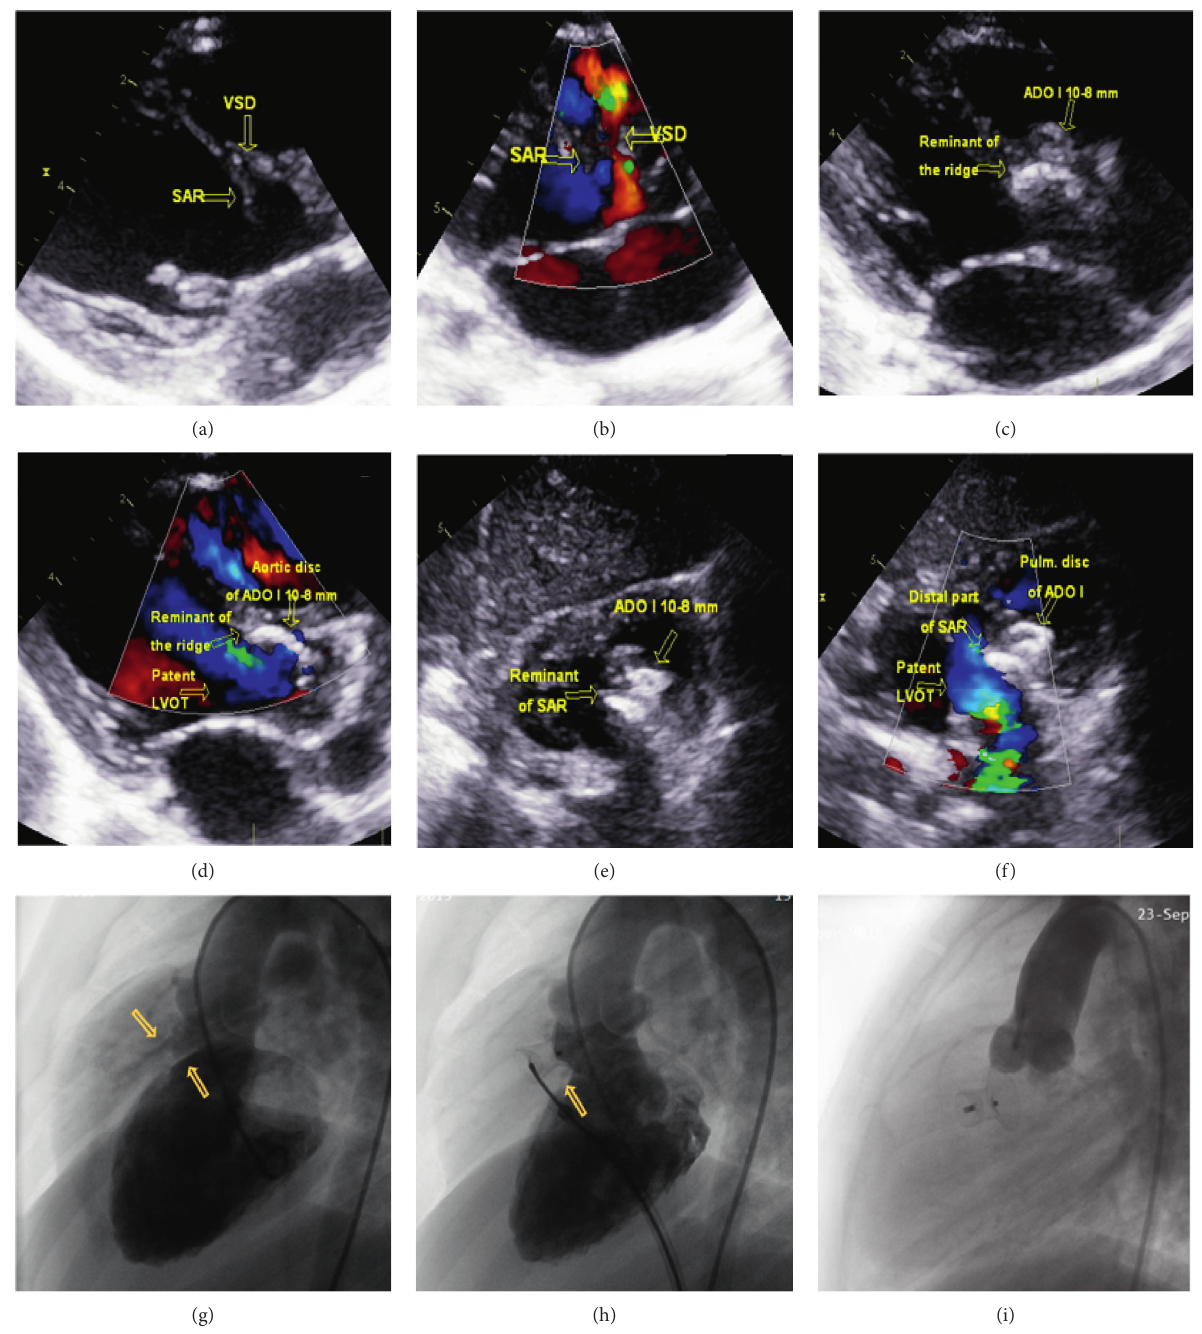
Figure 3: (a) Cross-sectional echocardiogram in the long axis parasternal view of a four-year-old male patient demonstrates peri- membranous subaortic VSD (upper arrow) distal to the subaortic ridge (lower arrow). (b) Parasternal long axis 2D echocardiographic image with the color flow mapping demonstrating significant left-to-right shunt across the defect (arrow) with the subaortic ridge. (c) Echo- cardiographic parasternal long axis view shows ADO-I (10–8 mm) closing the defect and compressing the subaortic ridge against the IVS. (d) Parasternal long axis 2D echocardiographic image with color flow mapping demonstrating the optimum device position with neither residual shunt nor AR. (e) Echocardiographic subcostal view demonstrating proper position of ADO-I closing the defect and compressing the subaortic ridge against the IVS with patent LVOT. (f) Modified subcostal 2D echocardiographic image with color flow mapping demonstrating ADO-I closing the defect and compressing the subaortic ridge against the IVS with no residual shunt, patent LVOT, and no AR. (g) Left ventriculogram in the left anterior oblique (70 ° ) and cranial (20 ° ) projection demonstrates a small-to-moderate size subaortic VSD (upper arrow) with a filling defect below the VSD that represents the subaortic ridge (lower arrow). The peak systolic pressure gradient across the LVOTwas 16mmHg. (h) Left ventriculogram in the left anterior oblique (70 ° ) and cranial (20 ° ) projection documents good device deployment with no residual shunt. (i) Aortogram in lateral (90 ° ) and cranial (20 ° ) projection, demonstrating no AR despite prolapse of the NCC. The peak systolic pressure gradient across the LVOT decreased to